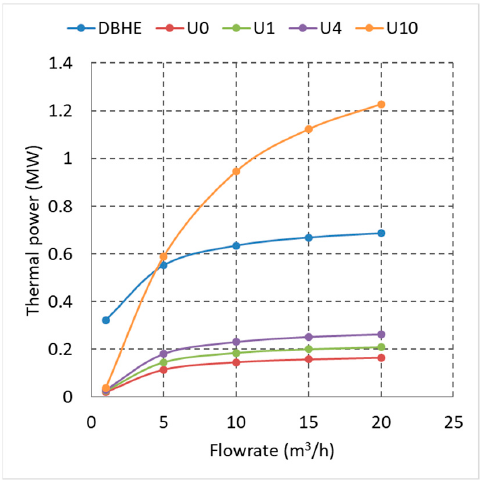
Figure 13. Thermal power vs flow rate (after six months of startup). Beckers et al. [36] assumed a base with a reservoir temperature range of 150–300 °C at a depth of 2 km. Their condition fits our case study with a depth of 2 km and a reservoir temperature of 300 °C. Table 5 shows the results ten years after startup. The most crucial difference is the flow rate. In our study, we adopted a low flow rate compared to the base case in [36]. Other differences influencing the results are the more significant thermal con- ductivity (34.7%) and density (29.5%). In any case, the results are similar.